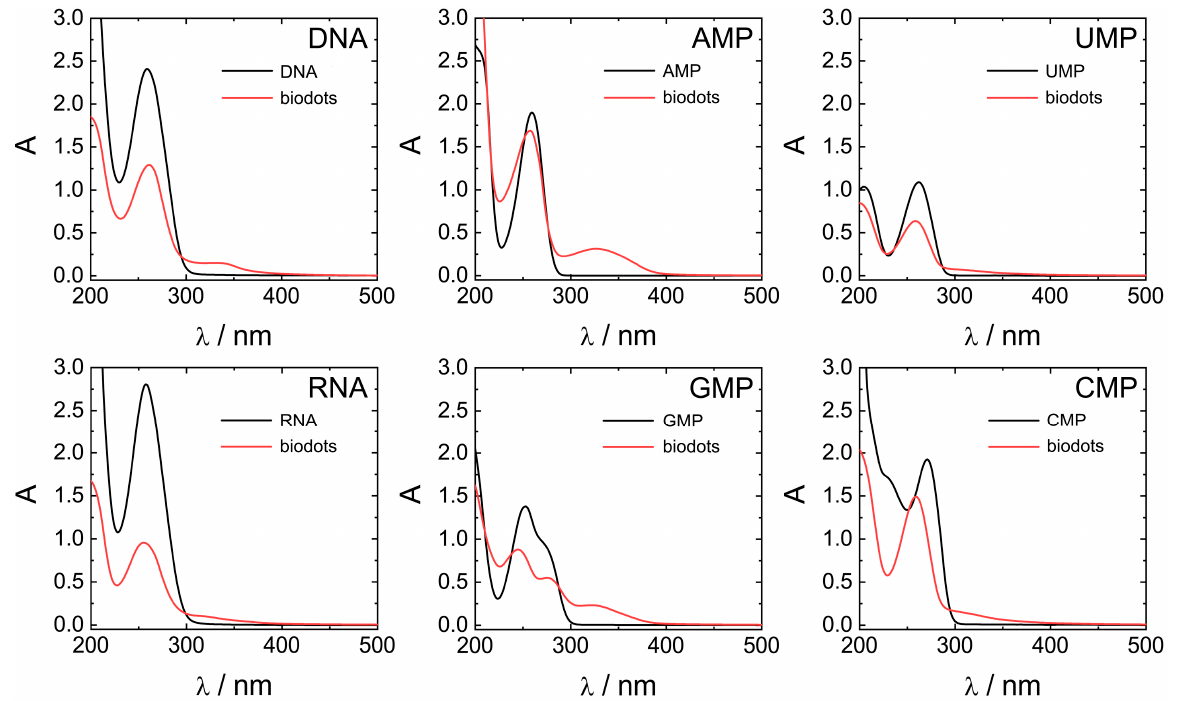
Figure 6. Comparison of UV-vis absorbance properties of nucleic acids and biodots. UV-vis spectra of 0.02% ( w / v ) solutions of nucleic acids and the corresponding 0.02% ( w / v ) solutions of